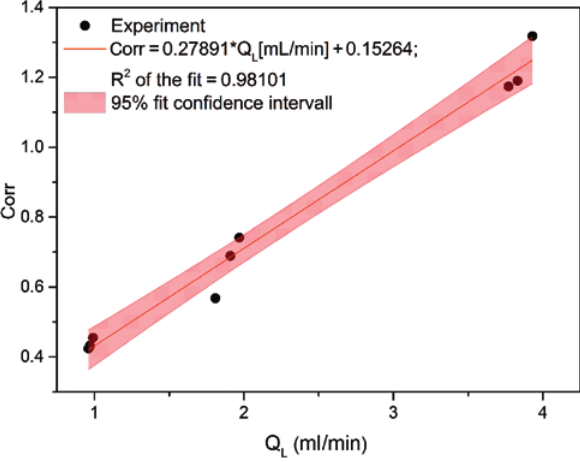
Figure 4: Correction factor depending on the incoming liquid volume flow rate.